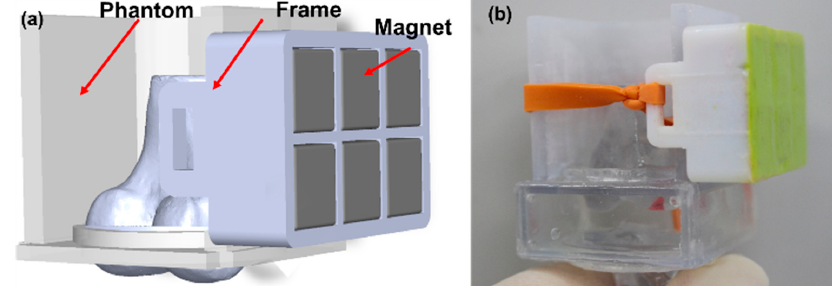
Figure 7. Wearable fixation device comprising a Halbach magnet array and a band wrapped around a phantom: ( a ) drawing and ( b ) prototype.